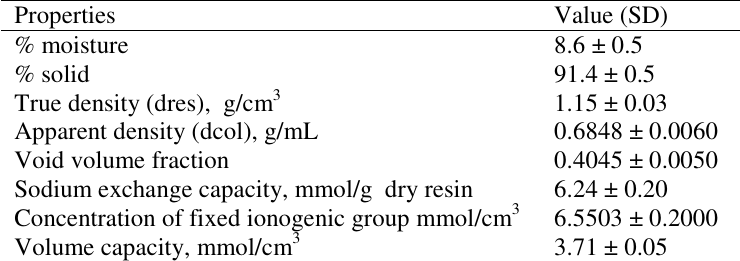
Table 1 . Physical properties of AFM